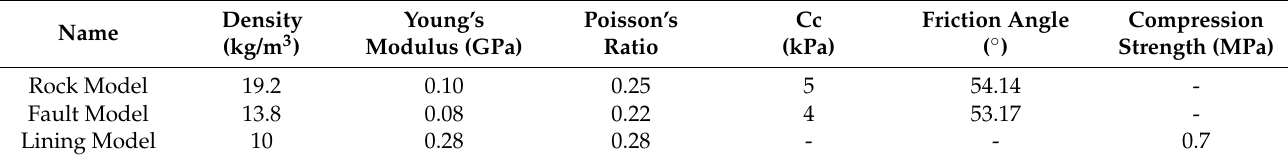
Table 2. Mechanical Parameters of the